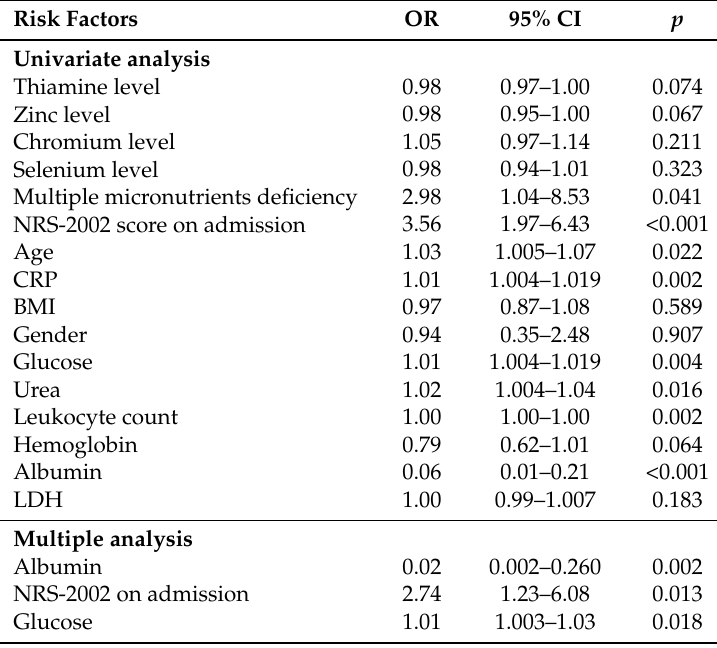
Table 3. Results of univariate and multiple logistic regression analysis for risk factors for SIRS.